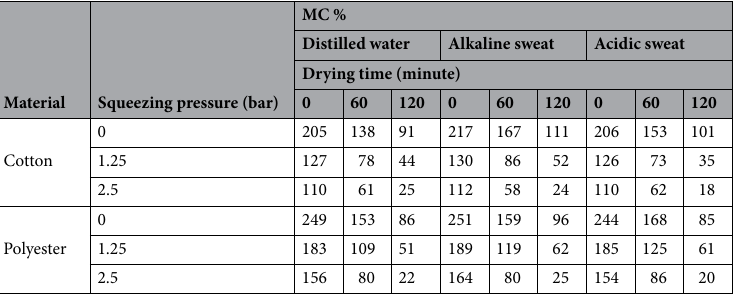
Table 2. Moisture content (MC %) of the cotton and polyester fabric